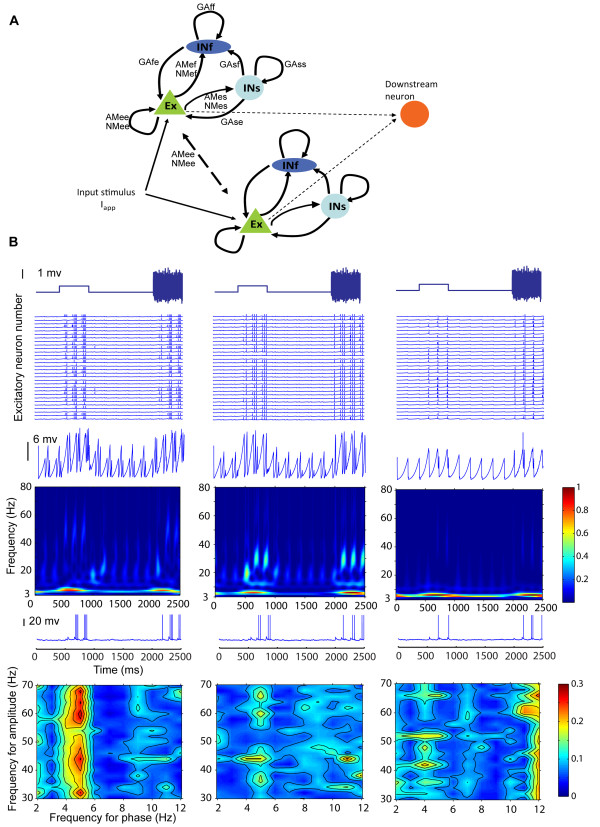
Neural network model and simulations showing effects of altering theta and gamma contributions on excitatory output neuron and downstream neuron activity. (A) Schematic showing connectivity in the neural network model together with the coefficient variables representing AMPA (AM), NMDA (NM) and GABAA (GA) receptors (INs = slow and INf = fast inhibitory neurons, Ex = excitatory neurons; lower case letters indicate direction of connectivity - s = INs, f = INf and e = Ex - i.e. NMes = NMDA receptor activated by connection from Ex to INs neurons). (B) Responses to both a ramped and white noise stimulus (top. Iapp = 0.8) (top panel) made by excitatory neurons (second panel)), LFP (third panel), the power contribution of different frequencies across the theta/gamma range (fourth panel), the downstream neuron (fifth panel) and coupling of theta phase and gamma amplitude (bottom panel). Data in the three columns are from a single run of the model using different parameter settings (Left, shallow theta-nested gamma with a theta/gamma ratio 3.4:1; middle, deep theta-nested gamma with a theta/gamma ratio 2.7:1; right, minimal gamma with a theta/gamma ratio of 10:1).